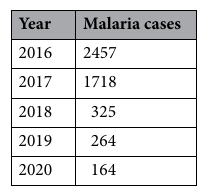
Table 3. Number of malaria cases in 10 endemic blocks (before and after LLIN distribution) of Purulia district from 2016 to